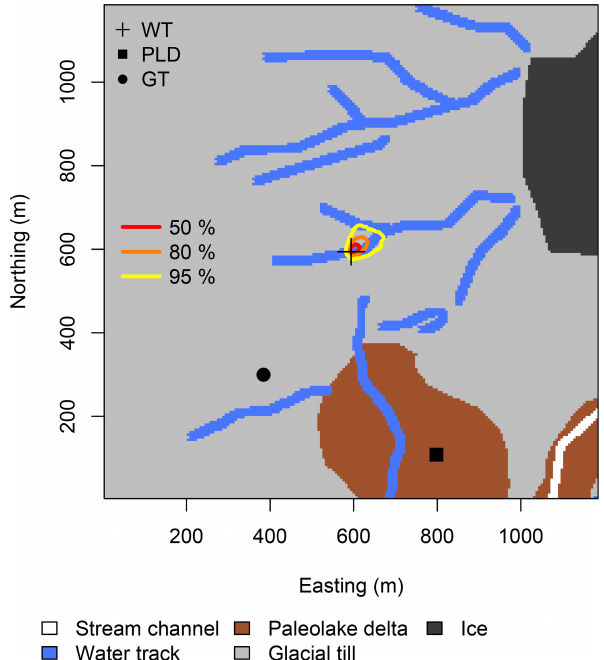
Figure 3. Excerpt of the land cover matrix for lower Taylor Valley with eddy-covariance station locations on water track (WT), paleo- lake delta (PLD), and glacial till (GT) surfaces. Extent of the flux footprint of WT is indicated by three probability density